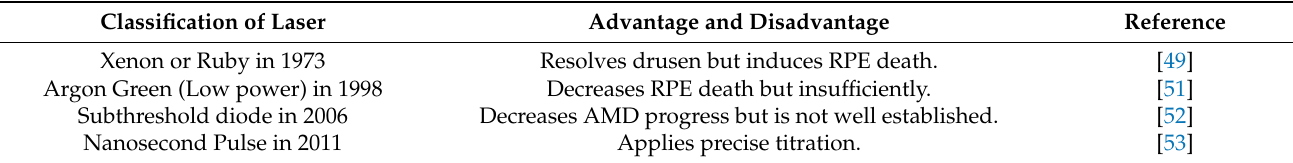
Table 3. Summary of the prophylactic/photocoagulation laser therapeutics .